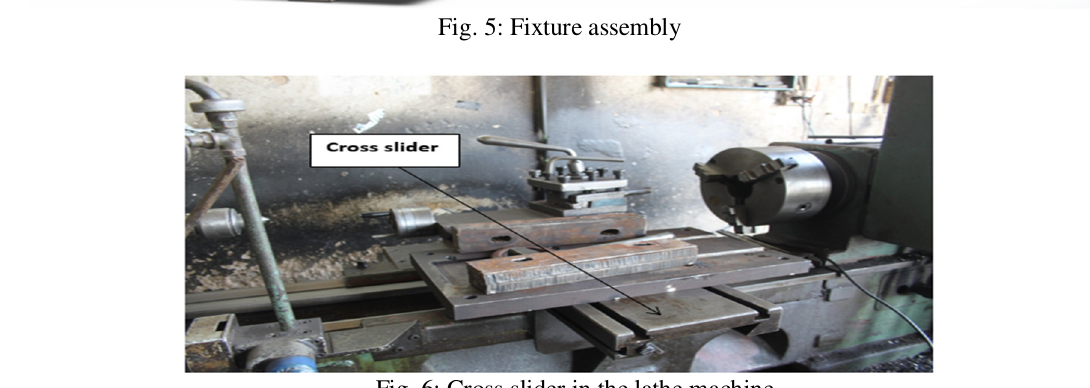
Fig. 6: Cross slider in the lathe